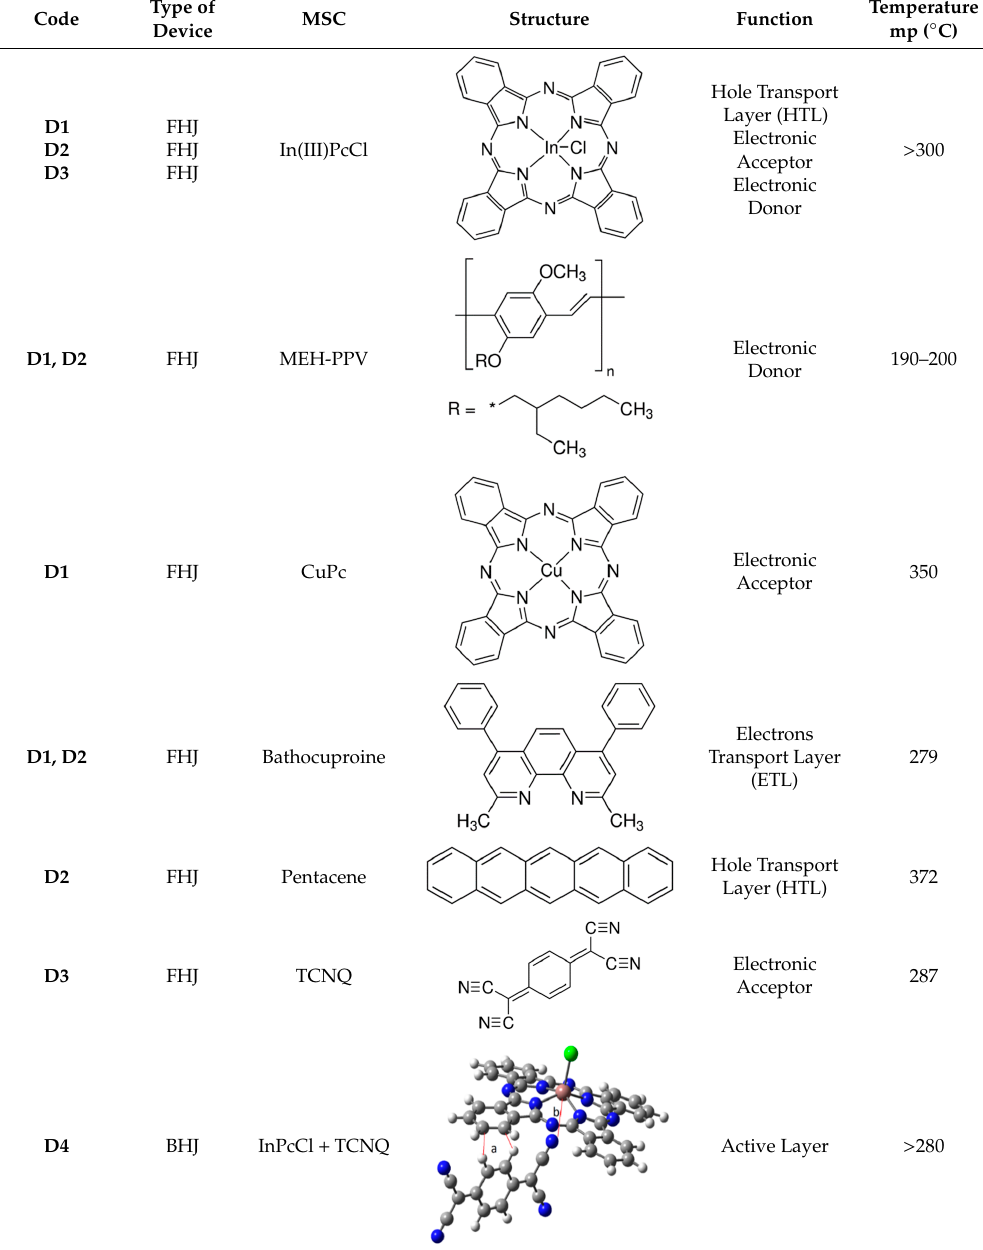
Table 1. Type of device with their constituents and the function of each one.